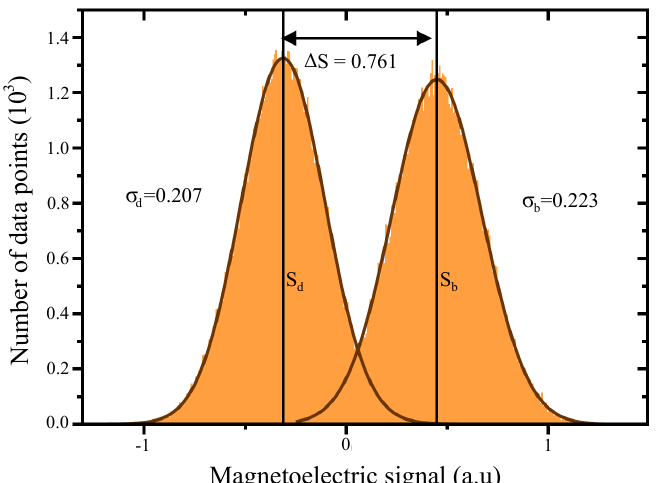
Figure 5. Histogram taken in an area of 900 µ m 2 in the two opposite antiferromagnetic domain states of the magnetoelectric scan in Figure 3b. Their average values S b , d correspond to the magnetoelectric signal of the bright and the dark domain, respectively, and the corresponding standard deviations σ b , d parametrize the noise of the